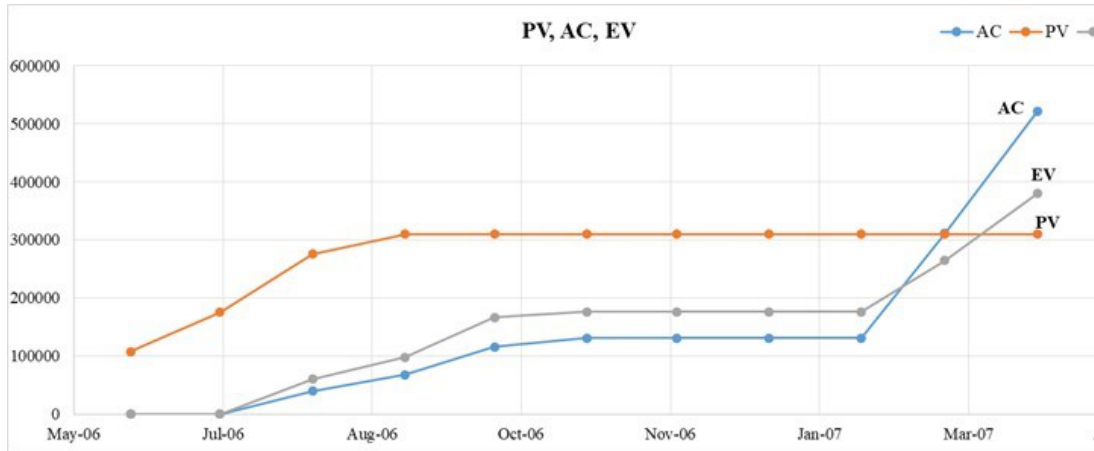
Figure 4: PV, AC, EV [authors’ data]